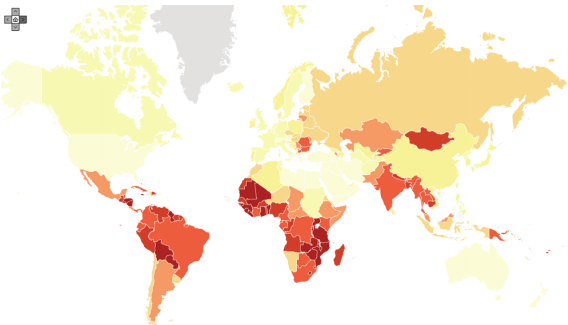
Figure 1: Estimated cervical cancer incidence worldwide in 2008. GLOBOCAN 2008, International Agency for Research on Cancer. The red and dark highlighted areas have the highest incidence